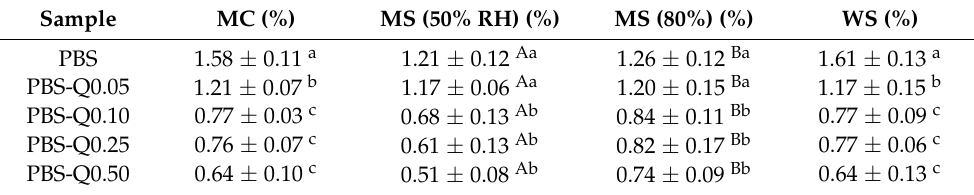
Table 4. Moisture content, moisture sorption (MS) and water sorption (WS) of PBS-based